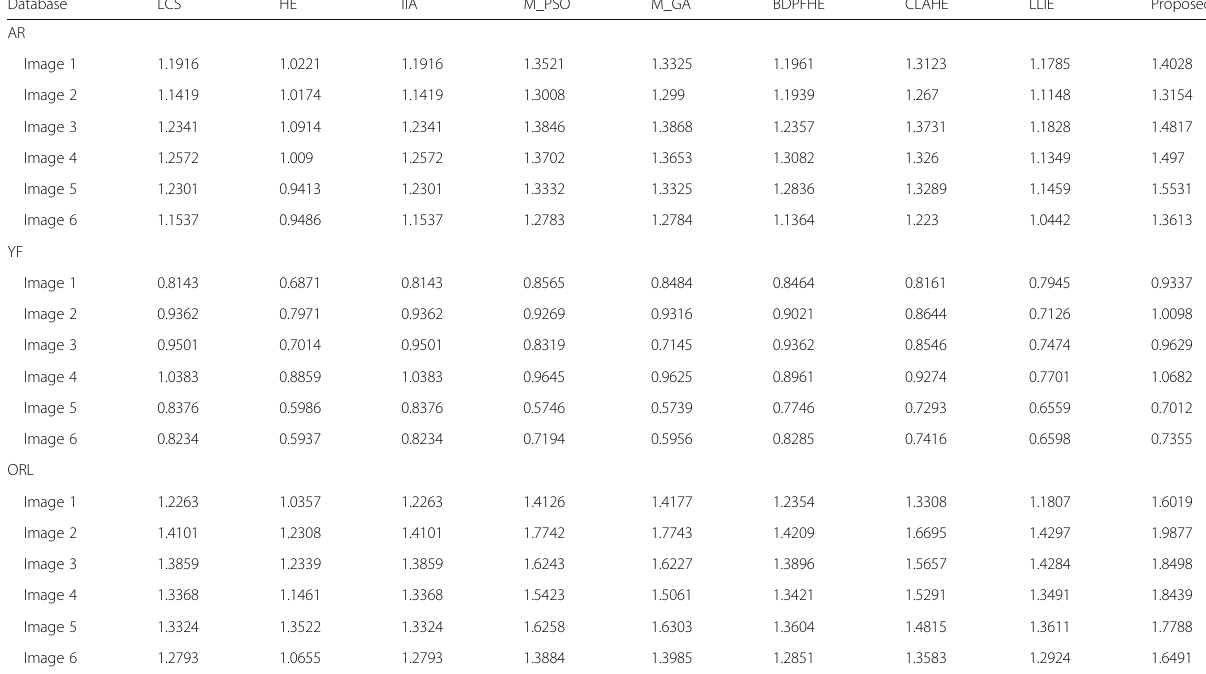
Table 9 Fitness value comparison between results obtained using different enhancement methods on standard benchmark face